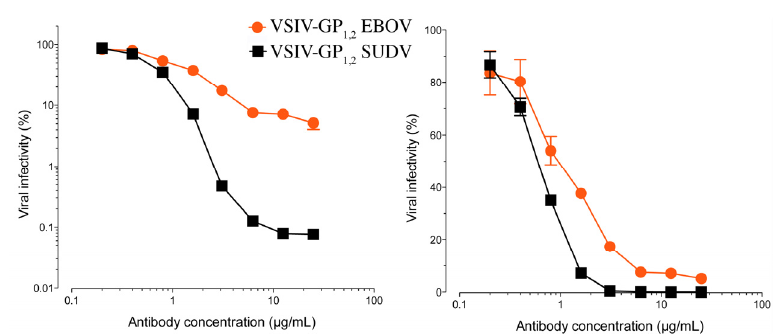
Figure 9. The ability of 16F6 and KZ52 IgGs to neutralize SUDV GP -bearing VSIV, plotted in a log (A) and linear (B) scales. VSIV particles were pre-incubated GP 1,2 with the indicated concentrations of antibody for one hour at room temperature, and then exposed to Vero cells at 37° C. Viral infectivity was scored at 16 hours post-infection. The starting titers were 9  10 7 IU/ml for EBOV and 3  10 7 IU/ml for SUDV on Vero cells